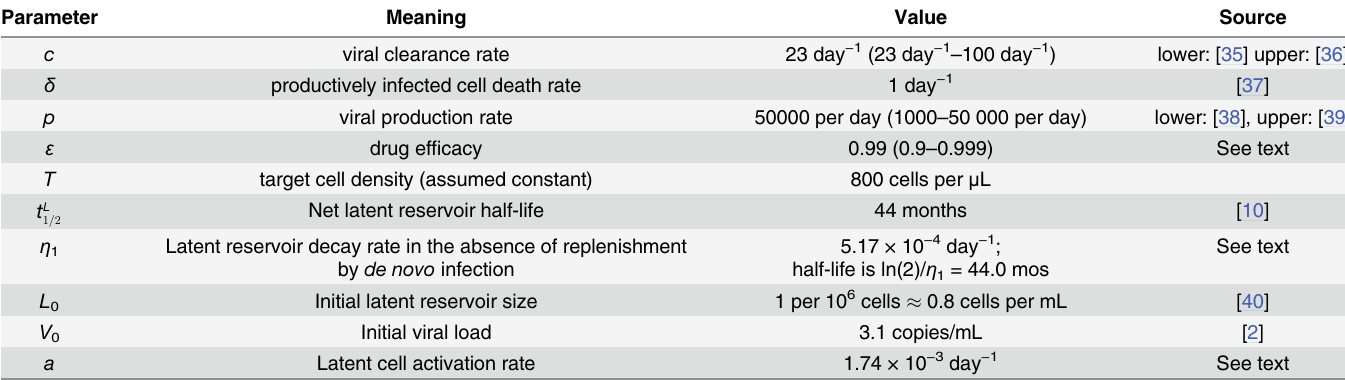
Table 1. Initial conditions and baseline parameters, with parameter ranges given in parentheses.